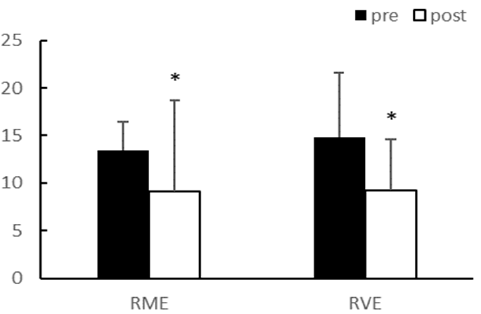
Figure 8. Leptin (mg/dL). Significantly different pre vs. post at * p <